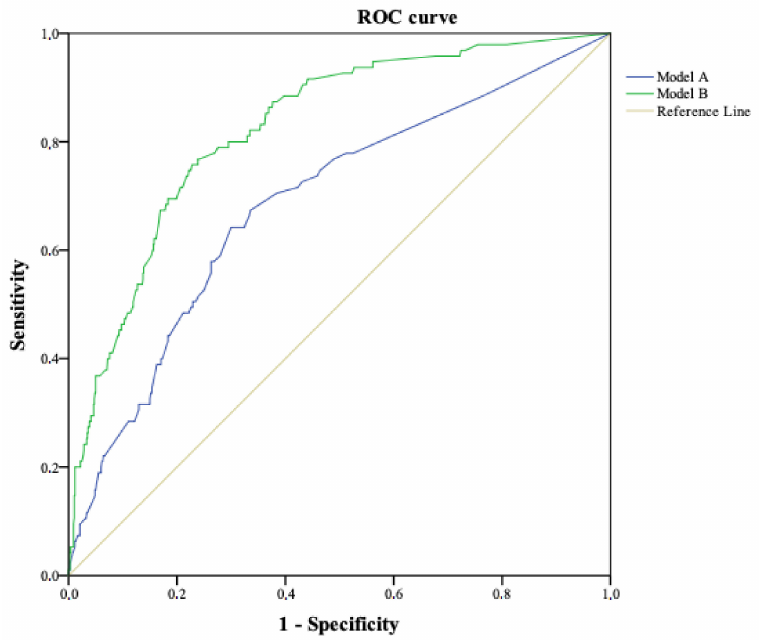
Figure 2. Predictive capacity of model A and model B in the validation cohort. Area under the ROC curve to determine the predictive ability of the model in the validation cohort, representing the sensitivity on the y axis and 1-specificity on the x